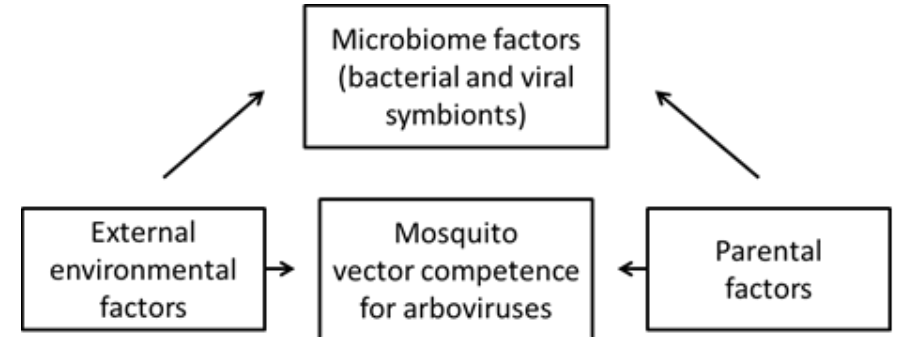
Figure 7. Mosquito vector competence for arboviruses can be affected by external and internal factors.